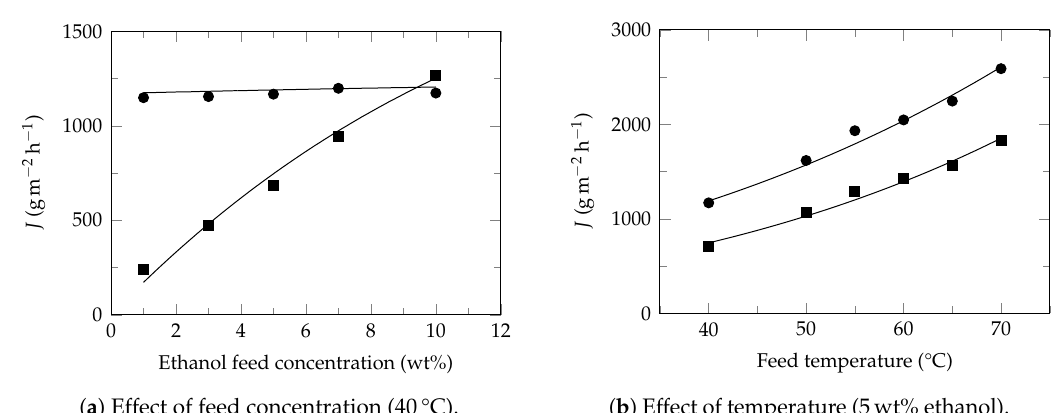
( b ) Effect of temperature (5wt% ethanol).